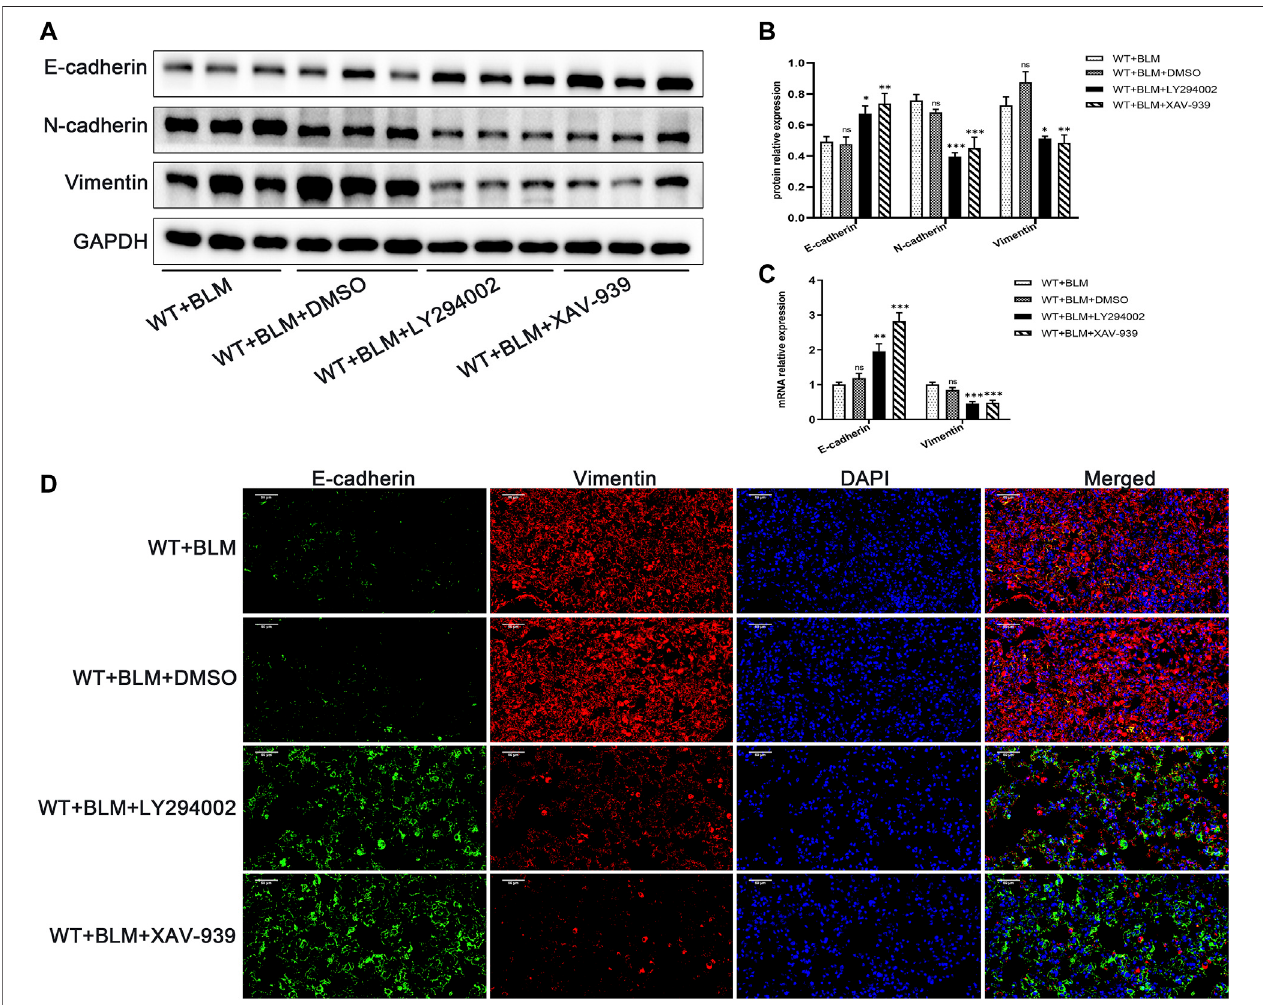
FIGURE 6 | Inhibition of the PI3K/AKT/GSK-3 β / β -catenin signaling pathway repressed EMT in the BLM-induced pulmonary fi brosis murine model. WT mice administrated by BLM were treated with or without LY294002 or XAV-939 or DMSO for 21 days. (A) The protein expression of E-cadherin, N-cadherin and Vimentin in the lung tissues of mice were measured by western blotting. (B) Statistical analysis of relative expression levels of proteins in A. (C) The mRNA expression of E-cadherin and Vimentin in the lung tissues of mice were assessed by qRT-PCR. (D) Dual immuno fl uorescent analysis for E-cadherin and Vimentin expression in the lungs tissueofmice.Scale bar=50 μ m n =6. Dataareshown asthemean±SEM.Statisticalanalysiswasperformedbyone-way ANOVA. * p < 0.05, ** p < 0.01,*** p < 0.001, ns p > 0.05.